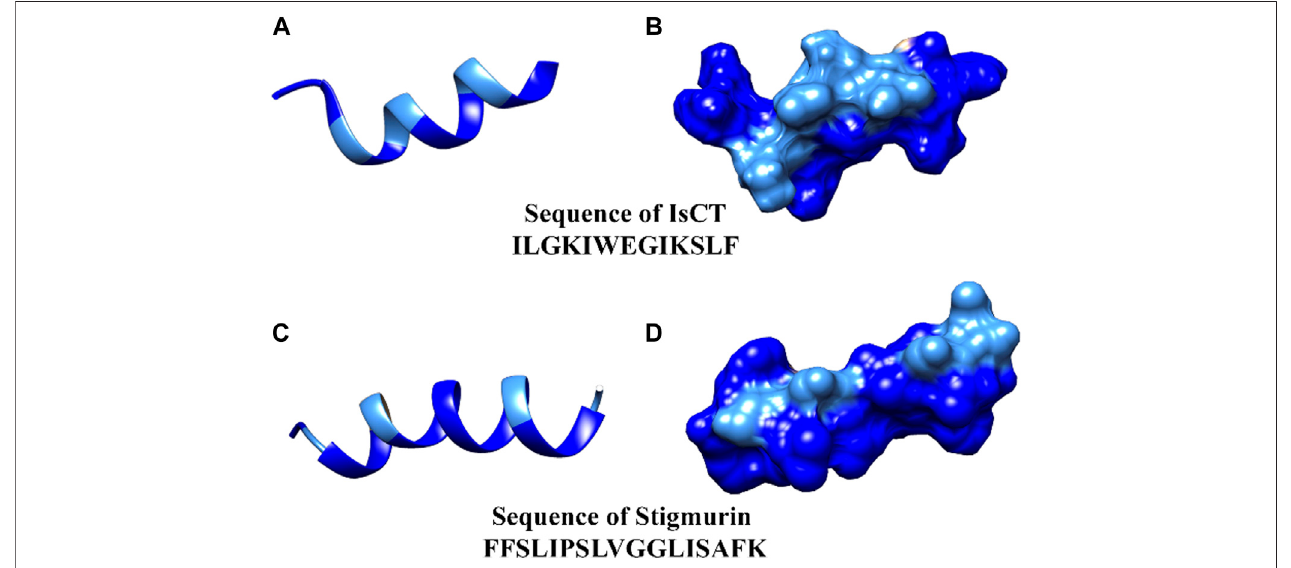
FIGURE2| TheoreticaltridimensionalstructureusingUCSFChimerasoftware(Pettersenetal.,2004)forthepeptidesIsCT (A) andStigmurin (C) .In (B,D) peptides IsCT and Stigmurin in electrostatic surface, respectively. Light blue and dark blue represent hydrophilic and hydrophobic regions,